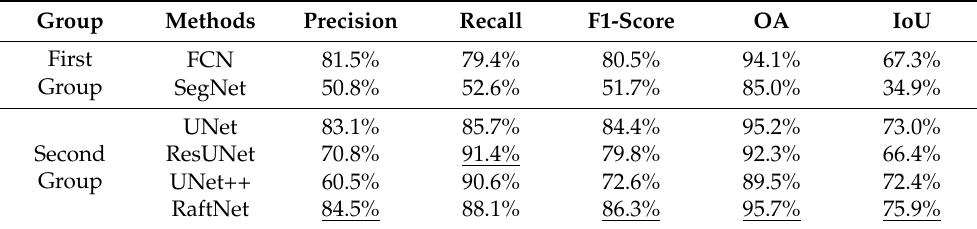
Table 4. Accuracy evaluation table of extraction results of different models (the best value is under- lined).